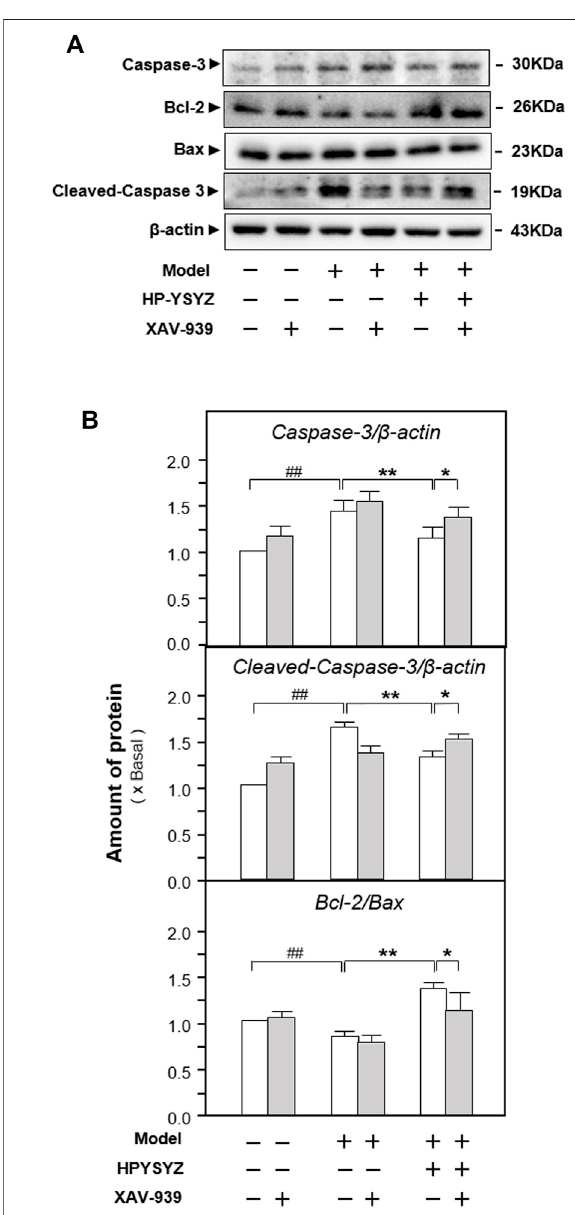
FIGURE7| Effectofco-treatmentofXAV-939andethylacetateextracts of succinum on the caspase-dependent pathway of hippocampus of carotid artery ligation rats. (A) Effect of ethyl acetate extracts of succinum (HPYSYZ) ontheexpressionsofcaspase-3,cleaved-caspase-3,Bcl-2,Bax,and β - actin in hippocampus of carotid artery ligation rats after co-treatment of XAV- 939 were evaluated by Western blotting analysis. The representative images are displayed ( n = 5). (B) Expression ratio of caspase-3 to β -actin, cleaved- caspase-3 to β -actin and Bcl-2 to Bax were calculated and the expression of β -actin was applied for normalization. Values are expressed as mean ± SEM ( n = 5). Comparisons between groups were carried out by a one-way ANOVA followed by a post hoc Bonferroni test. ## p < 0.01, * p < 0.05, and ** p < 0.01.